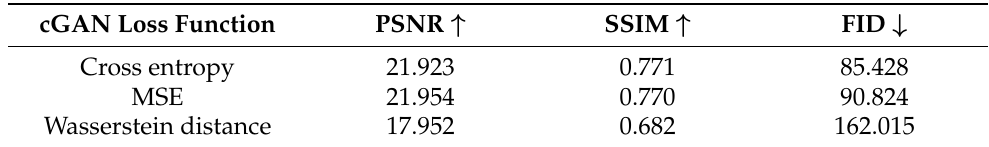
Table 3. Metrics of the different cGAN loss functions tested.